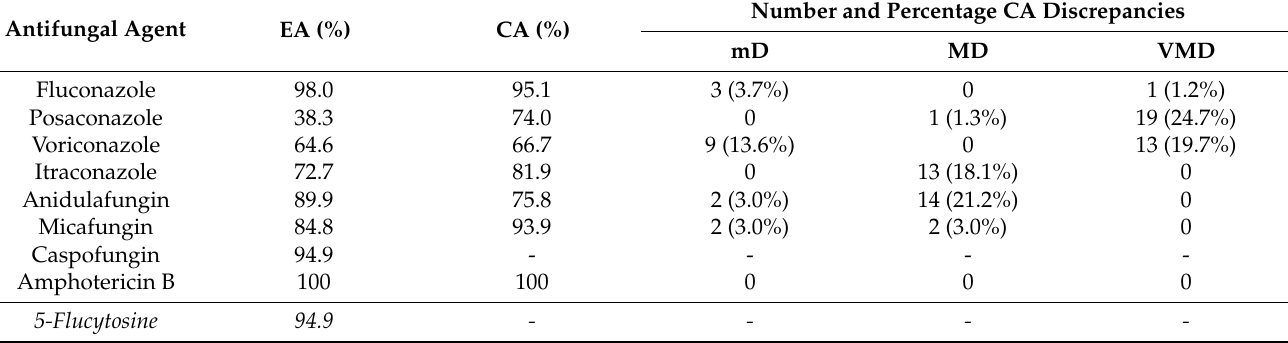
Table 3. The EA as the percentage of MICs within two twofold dilutions, the CA and the number and percentage CA discrepancies between SY and